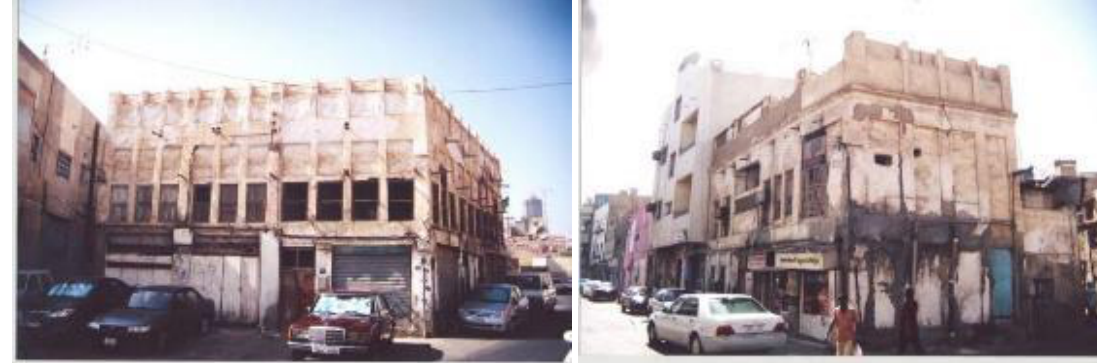
Figure 19. Haphazard car parking with low level of